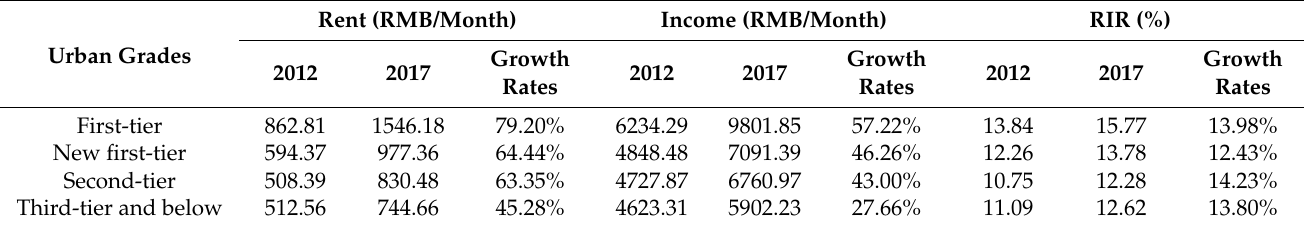
Table 4. Rent, income, and RIR of cities at different levels, 2012 and